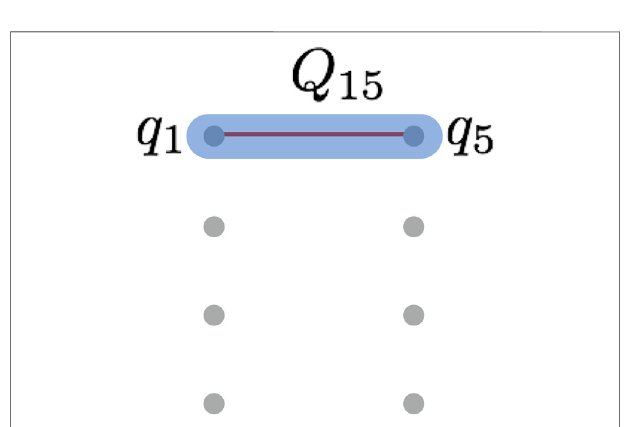
FIGURE 6 | A chain qubit. If the b 15 coupling is suf fi ciently negative then the spins q 1 and q 5 will have tendency to align in the same direction.